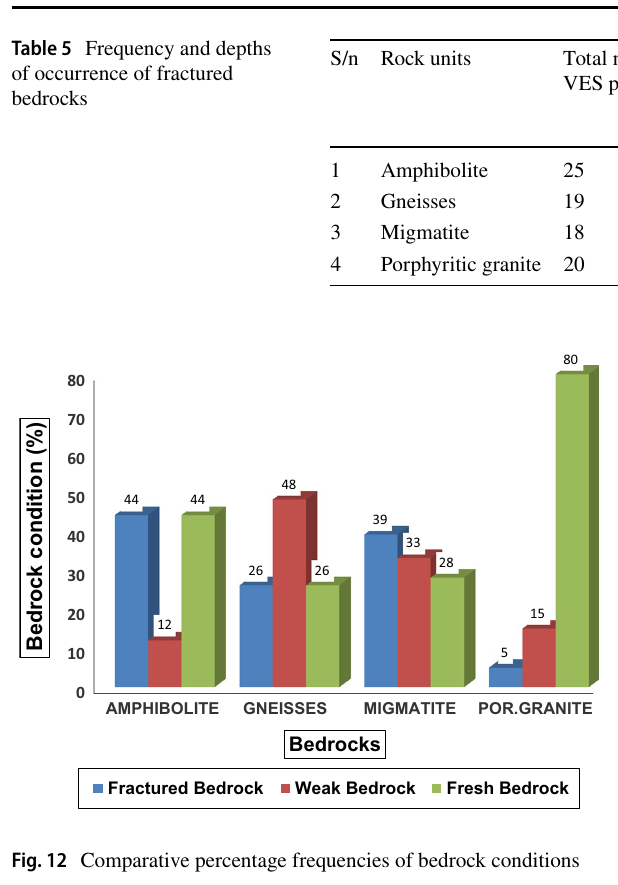
Fig. 12 Comparative percentage frequencies of bedrock